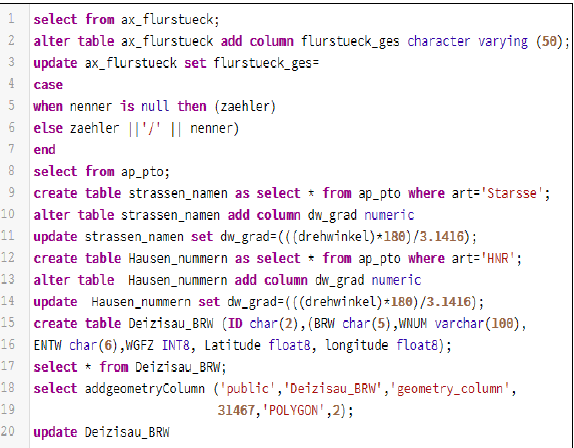
Figure 3: SQL code for layer preparation in the PostgreSQL database.